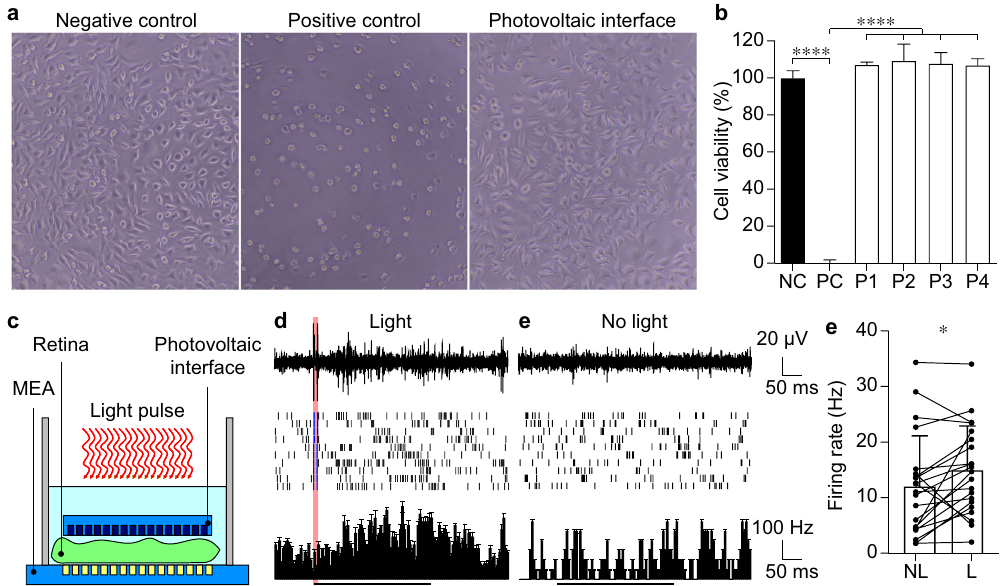
Fig. 9 Functional validation in vitro and ex vivo. a Representative images of in vitro cytotoxicity of the near-infrared-responsive photovoltaic prosthesis (right). Optical images of cell culture as negative control and positive controls are also shown (left and middle respectively). b Quanti fi cation of cell viability of the four prostheses tested (from P1 to P4) along with the negative and positive controls (respectively NC and PC). c Sketch of the setup used for ex vivo electrophysiology. d Representative response of one retinal ganglion cell upon NIR stimulation (10 ms, 4.7 mW mm − 2 ; identi fi ed by the red bar). The top row shows the electrophysiological recordings upon one NIR light pulse. The middle row shows the raster plots upon ten consecutive NIR light pulses. The blue lines in the raster correspond to the events classi fi ed as stimulus artefacts. The bottom row shows the corresponding mean post-stimulus time histogram (±s.d., bins of 5 ms). The 300-ms black bar corresponds to the time window averaged to determine the post-stimulus mean fi ring rate. e Electrophysiological recordings in the same retinal ganglion cell in d , without light pulses. f Quanti fi cation of the post-stimulus mean fi ring rate in retinal ganglion cells with (L) and without (NL) NIR light pulses ( n = 21 retinal ganglion cells; two-tailed paired t -test, p = 0.034). Bars are means±